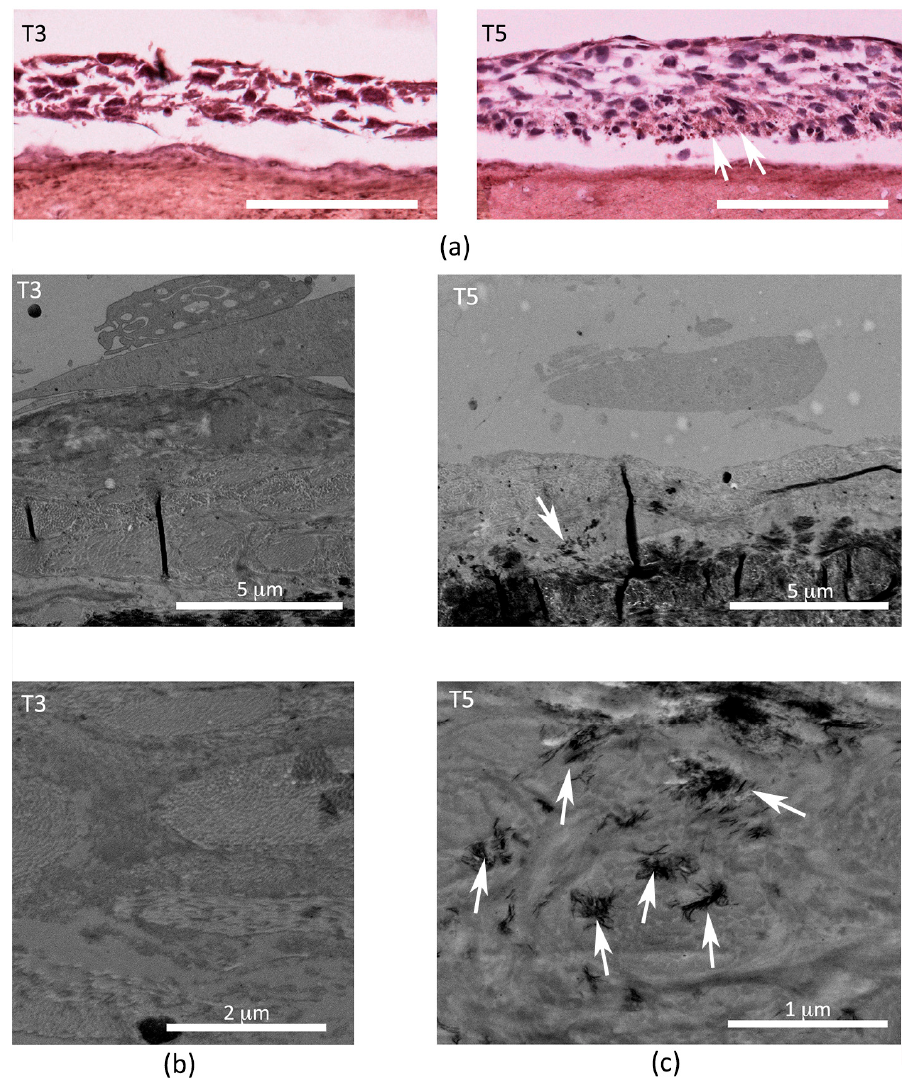
Figure 6. ( a ) Images of Immunohistochemistry (IHC) analysis show a brown staining indicating osteocalcin expression inside the cell layer after five days (T5) of differentiation (white arrows) and absence after three days (T3) of differentiation (scale bar 100 μ m). Transmission Electron Microscope (TEM) micrographs showing a transversal section of SO on which 2T3 were differentiated for ( b ) three days and ( c ) five days; top images are enlarged below: it is to be noted that the absence of any calcium deposition in T3 and presence of mineralization dots (white arrows) in T5.